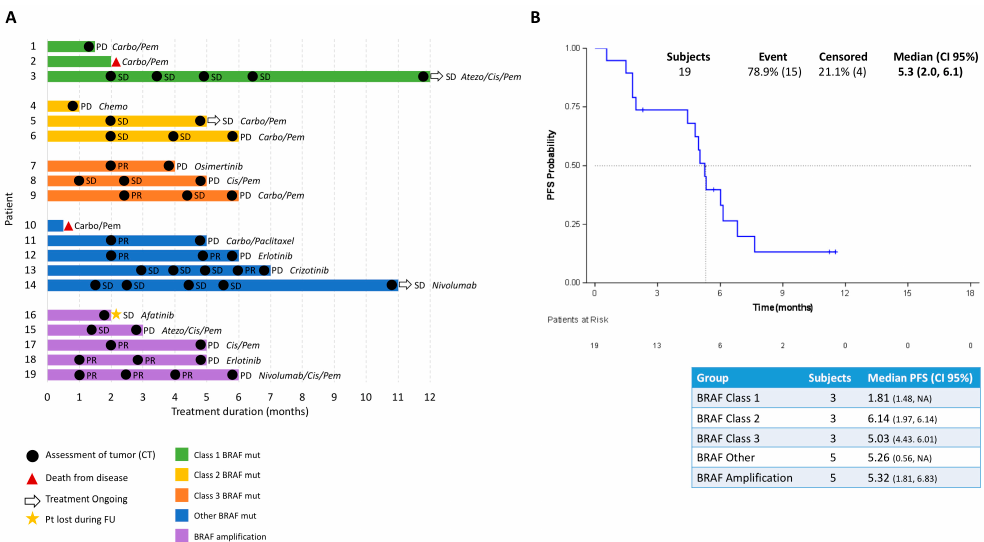
Figure 2. ( A ) Swimmer’s plot of time (months) on first-line treatment with clinical response for